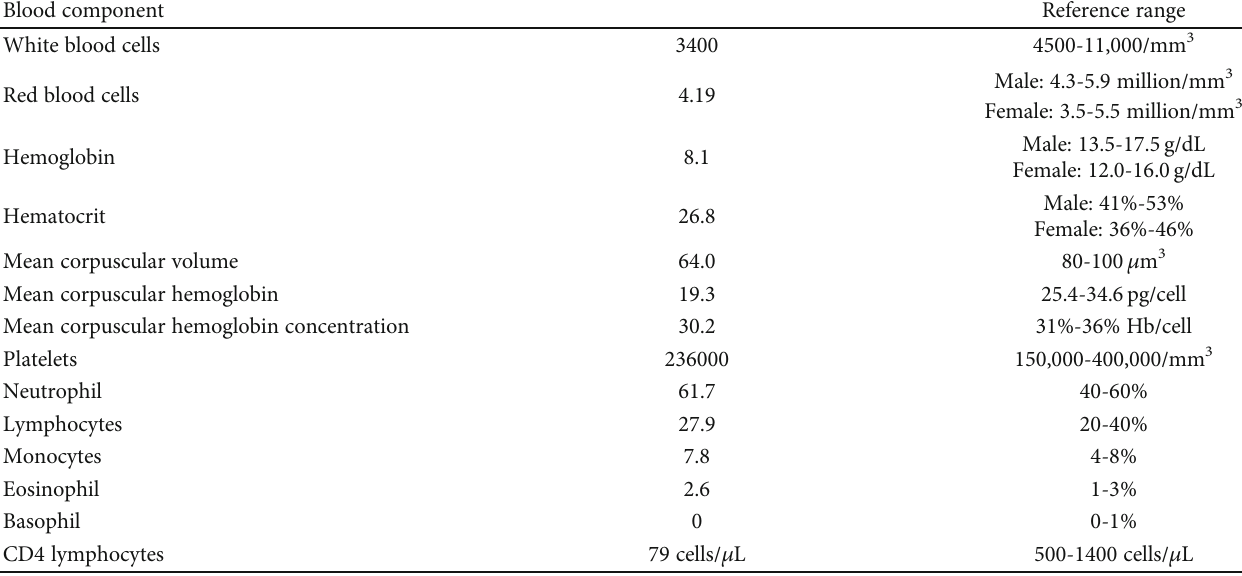
Table 1: The results of the patient ’ s CBC-di ff